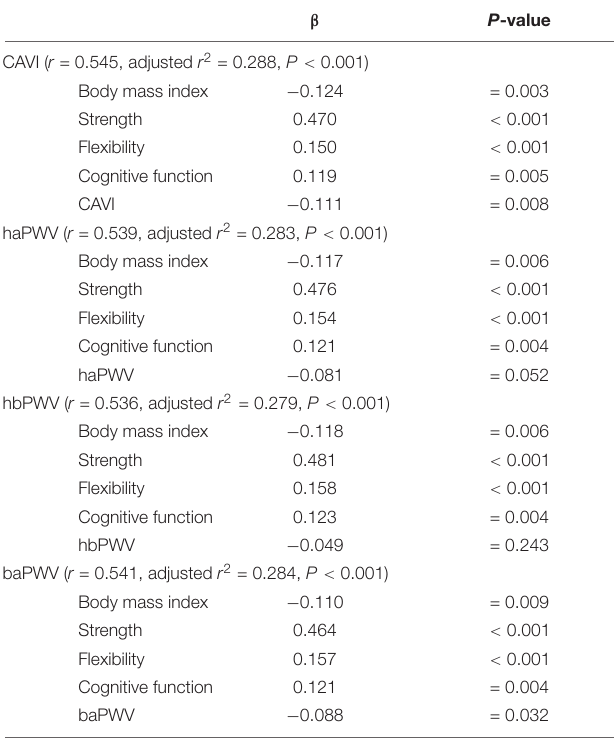
TABLE 2 | Multiple-regression analyses of each arterial stiffness index and physical factors affecting walking